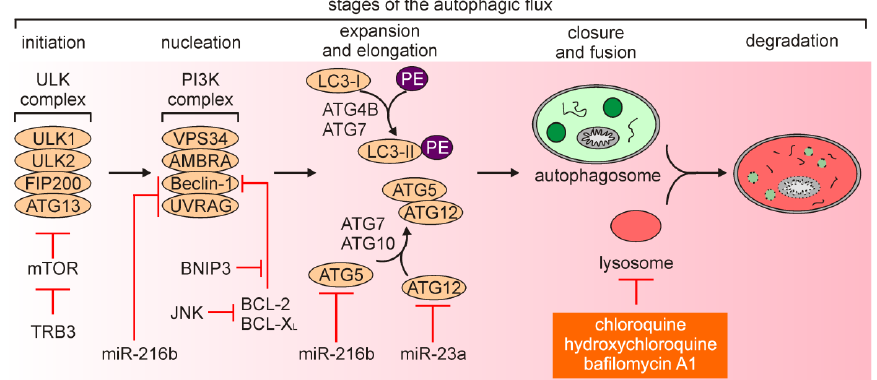
Figure 2. Stages and machinery of autophagy. Under nutrient starvation and other autophagy-inducing conditions, the autophagy flux is initiated by formation of the Unc51-like autophagy activating kinase (ULK) complex. The activated ULK complex participates in the recruitment of other proteins that constitute the phosphoinositide 3-kinase (PI3K) complex and proceed assembly of an initial double-membrane structure (phagophore). This stage of autophagy can be additionally regulated by the apoptosis-related proteins such as B-cell leukemia / lymphoma 2 (BCL-2) and B-cell lymphoma-extra large (BCL-X L ) as they can sequester Beclin-1. Elongation is mediated to form autophagosomes by two ubiquitin-like systems: (1) Autophagy-related genes(ATG)5 / ATG12 conjugation system, and (2) ATG4B- and ATG7-mediated processing and phosphatidylethanolamine (PE) conjugation to light chain 3 (LC3)-I (LC3-I:LC3-II conversion). PE-conjugated LC3-II associates with the autophagosome. The maturation of autophagosome is associated with the delivery of misfolded proteins and / or damaged organelles, and then autophagosome is fused with the lysosomes. The cargo is exposed to the lysosomal hydrolases, which are active under acidic conditions. Compounds that a ff ect the autophagic flux by disturbing lysosome acidification are shown in orange background. Mechanisms of autophagy regulation that have been shown in melanoma are additionally